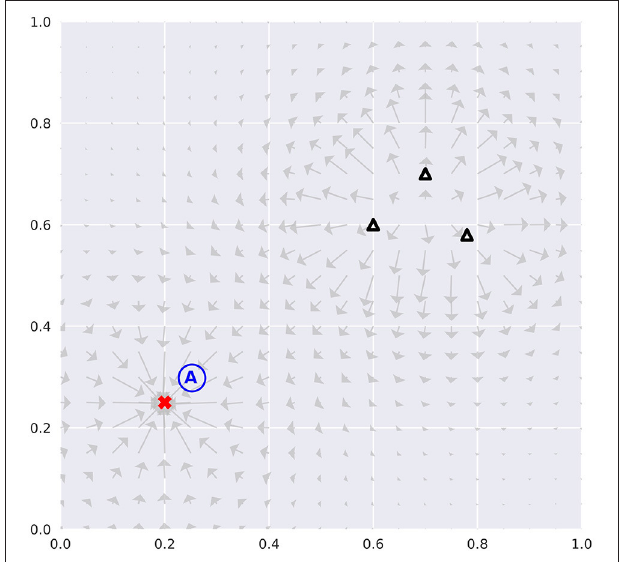
FIGURE 2 | Environmental configuration. The red cross represents an attractor, whilst black triangles repellers. Vector plots indicate the forces exerted if the agent assumed the positions with zero velocities. The initial position is set at the blue letter “A.” This configuration remains identical cross all model variants and test